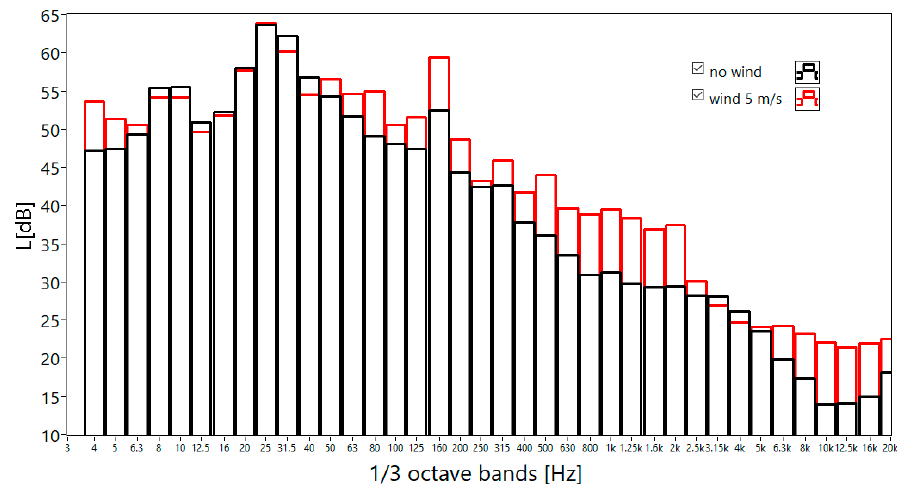
Figure 9. Ventilation shaft noise. One-third octave spectrum for the measurement on the board with a double shield—wind speed 0 m/s (black), wind speed 5 m/s (red). The spectrum obtained for the signals recorded at the average wind speed of 6.5 m/s is presented in Figure 10. In bands below 25 Hz, also the most reliable (closest to the results obtained during windless weather) were obtained for the measurement on the board with a double windshield.